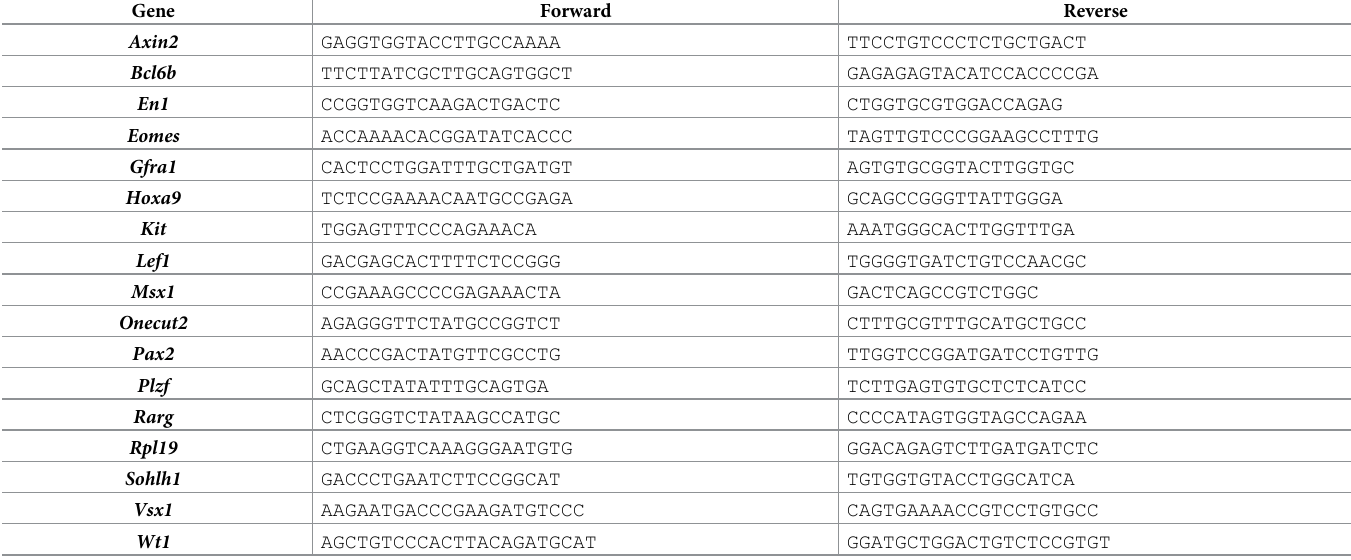
Table 1. Quantitative RT-qPCR primer